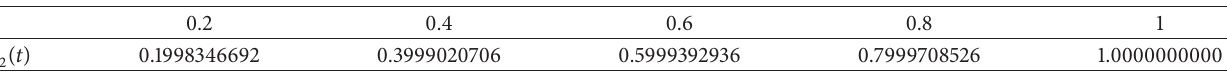
Table 2: Some numerical values of the solution ̃𝑥 2 (𝑡) of (67)-(68) with 𝑁 = 2 , close to the values of the global minimizer 𝑥(𝑡) = 𝑡 of the fractional variational problem of variable order (54)-(55).